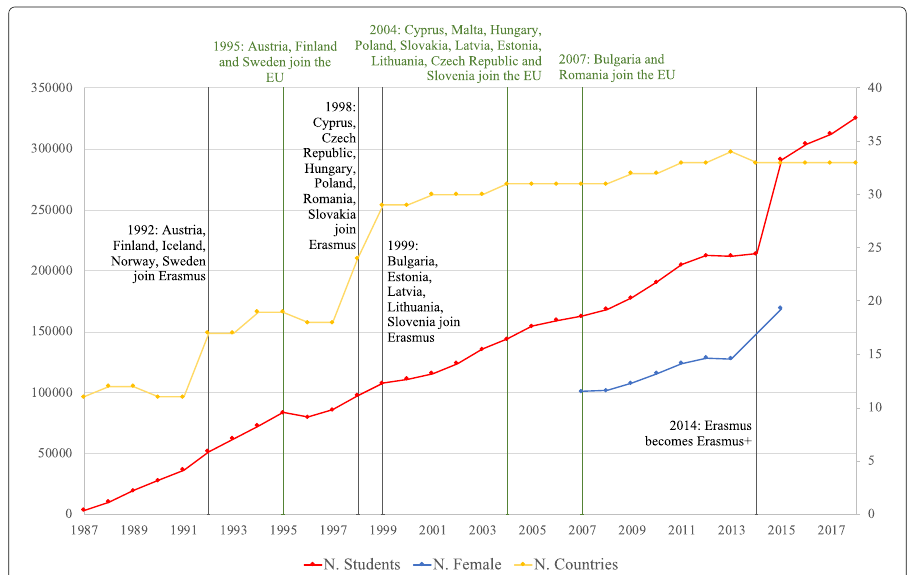
Fig. 1 The history of Erasmus program from 1987 to 2018. The evolution of the Erasmus program is represented in terms of countries and students on mobility only for study reasons. The red line represents the number of mobile university students (left scale), the blue line represents the number of female university students on mobility only for the years in which the information is available (left scale), the yellow line represents the number of countries participating in the mobility (right scale). The grey vertical lines indicate the adhesion of new countries to the Erasmus program and the transformation of the program into Erasmus+. The green vertical lines identify some enlargements of the EU. Note that the value for the year 2014 is not an expost figure, but a projection (European Commission 2015). Data on the number of participating countries and students are extracted from the Erasmus annual reports (European